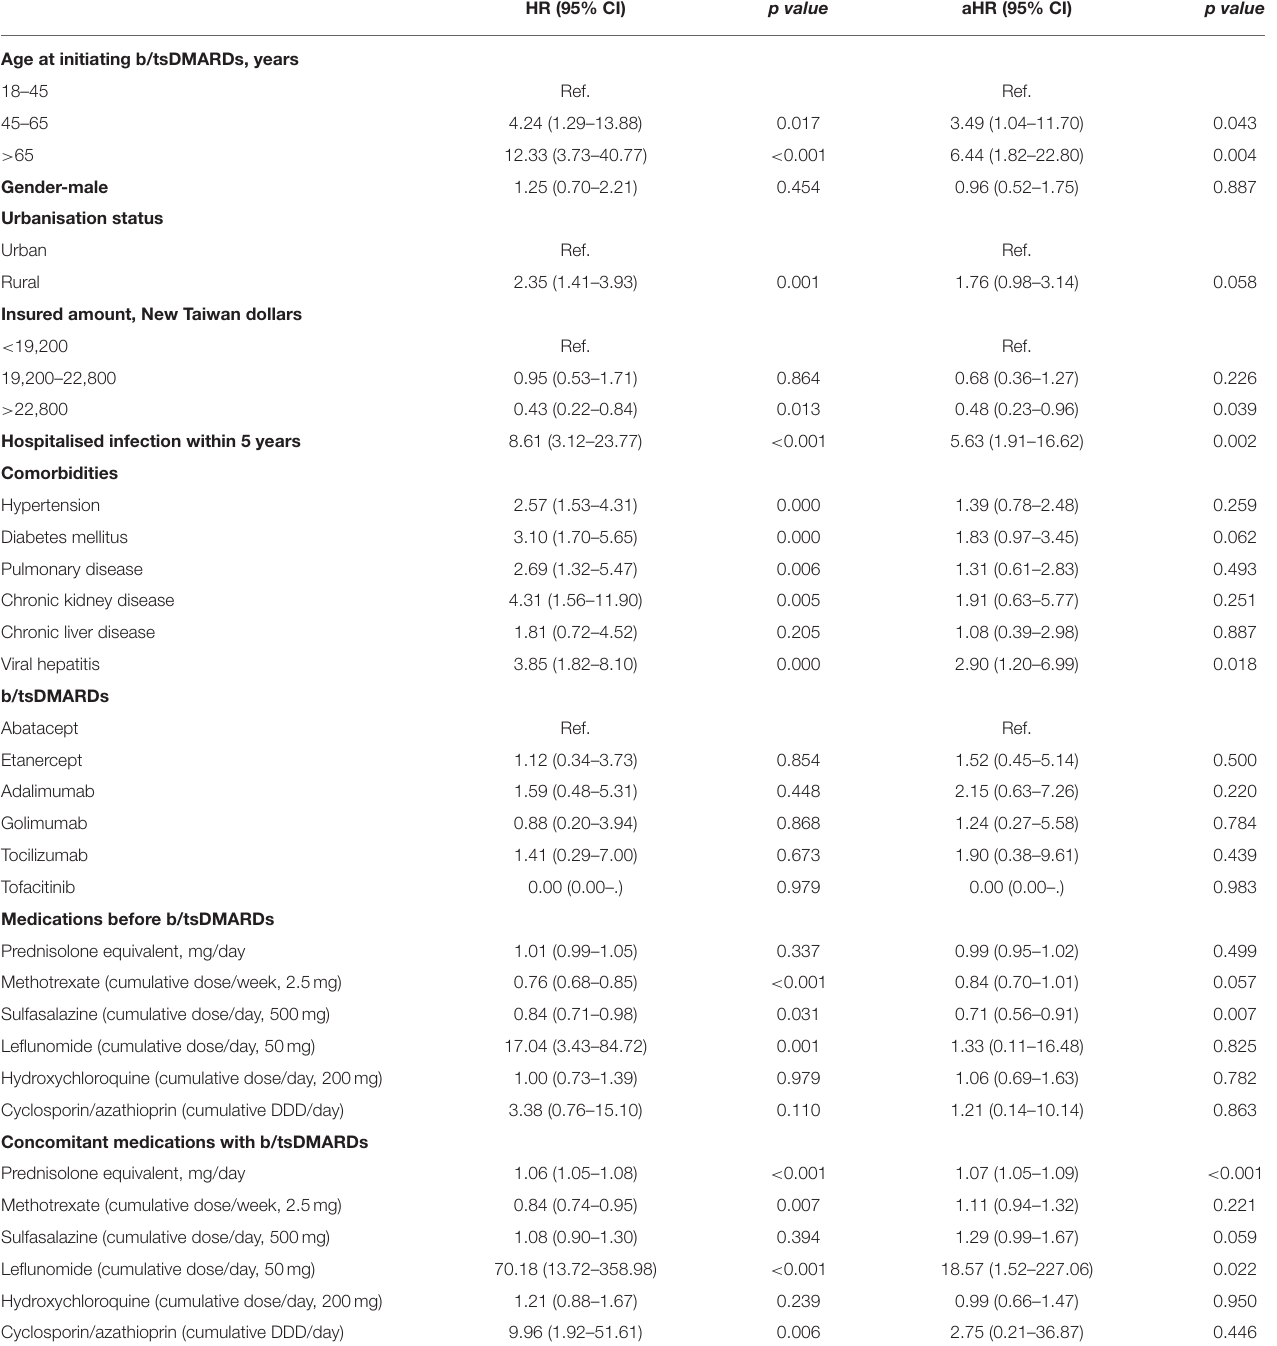
TABLE 3 | Crude and adjusted hazard ratios for the association between incident hospitalised infection and